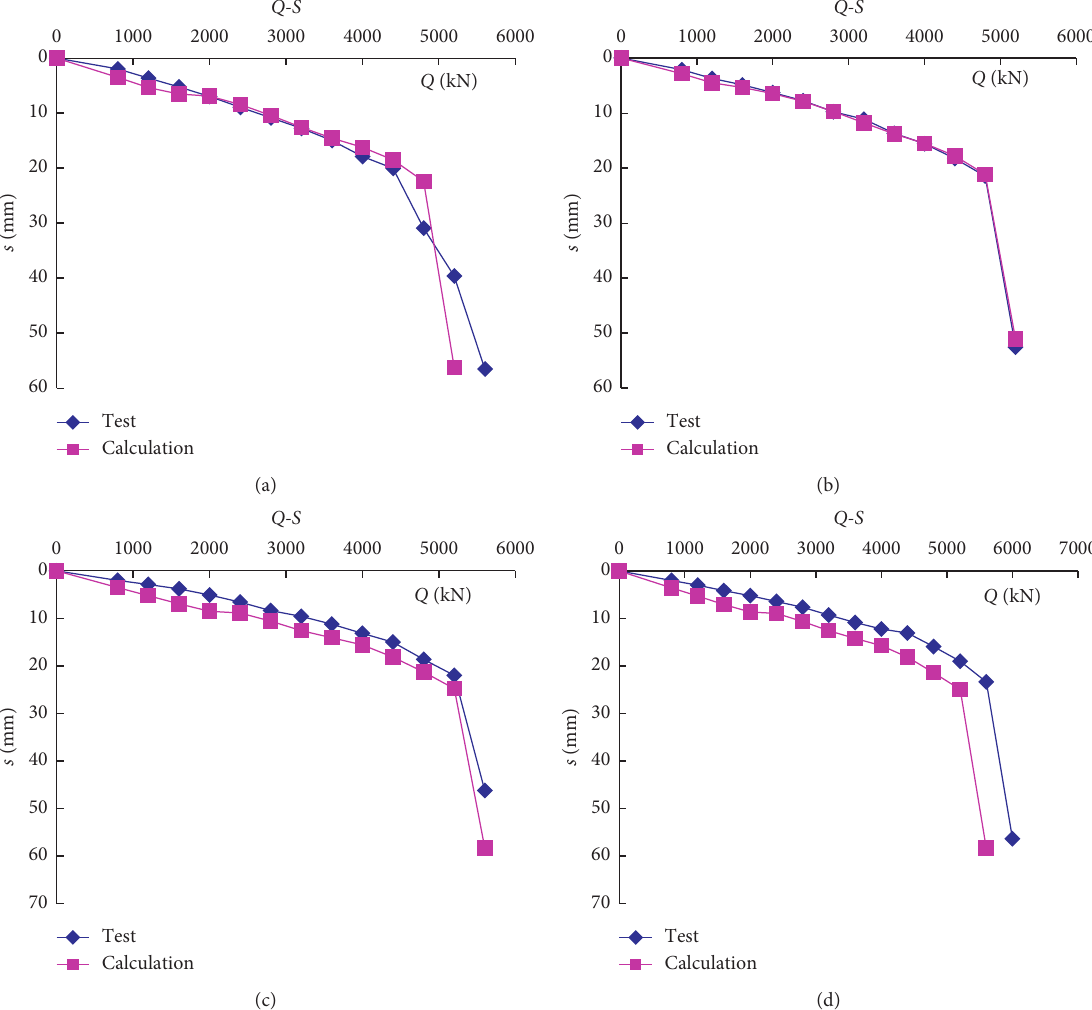
Figure 13: Comparing the results of numerical simulation and SLTs (at the soft rock bearing stratum site). (a) Pile #1. (b) Pile #3. (c) Pile #5. (d) Pile #6.